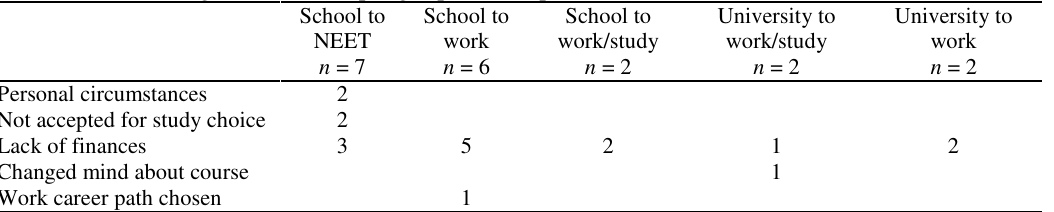
Table 1 Constraining factors interrupting aspirational paths